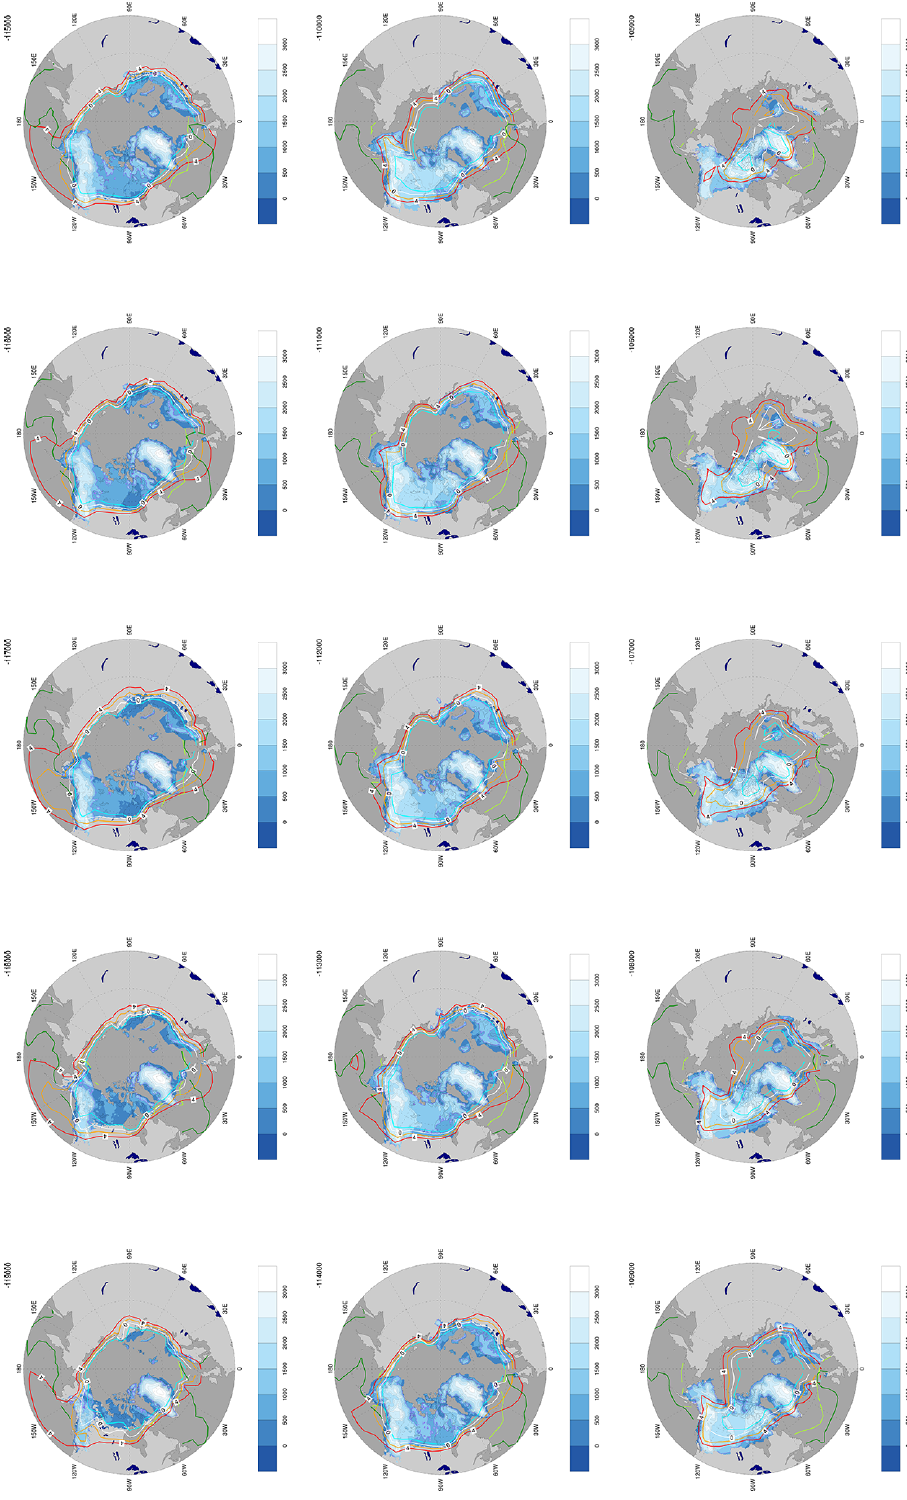
Figure 5. The evolution of ice sheet surface elevation (shaded areas in light blue–white gradient), 2m JJA temperature ( − 2 to 4 ◦ C), and sea ice seasonal maximum and minimum extent (dark and light green) for every 1kyr from 119 to 105ka for one of the best-fitting (to proxy sea-level records) simulations of the ensemble. The 1000m elevation contour is in